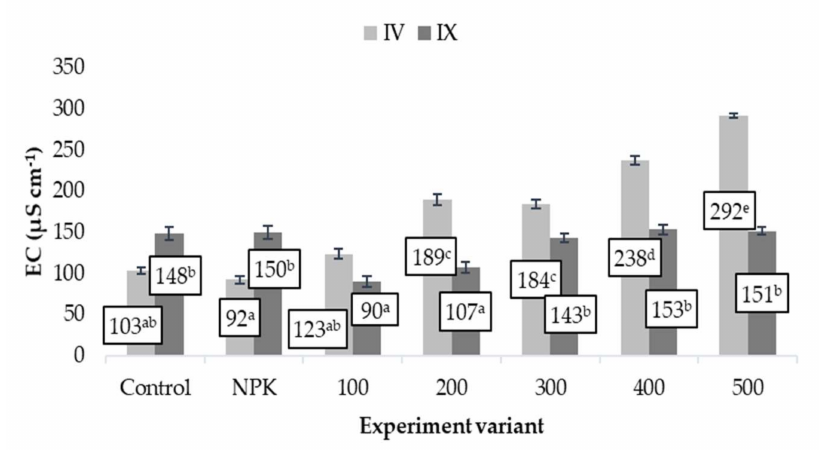
Figure 3. Changes in the salinity of the podzolic soil in the 0–5 cm layer in IV (April) and IX (September) 2021 after the application of biomass combustion ashes (mean ± SD). Treatments not sharing the same letter(s) are statistically significant at p < 0.05 (Tukey’s HSD).